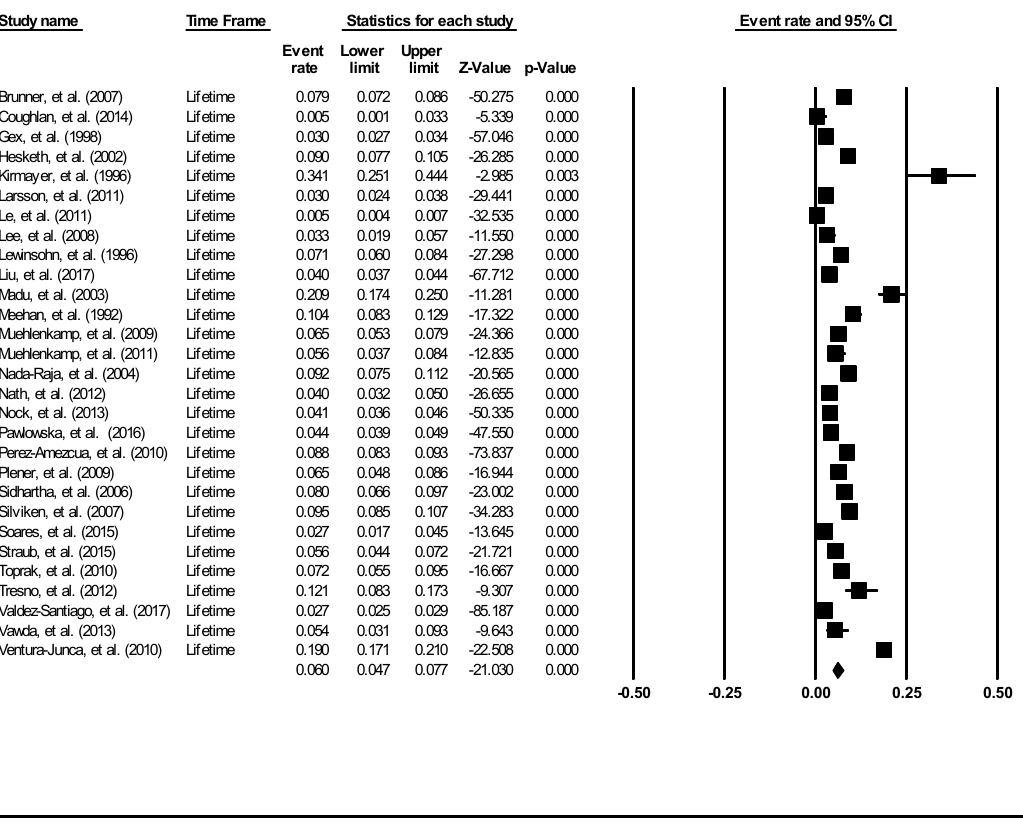
Figure 2. Forest plot of the aggregate lifetime prevalence of suicide attempts.